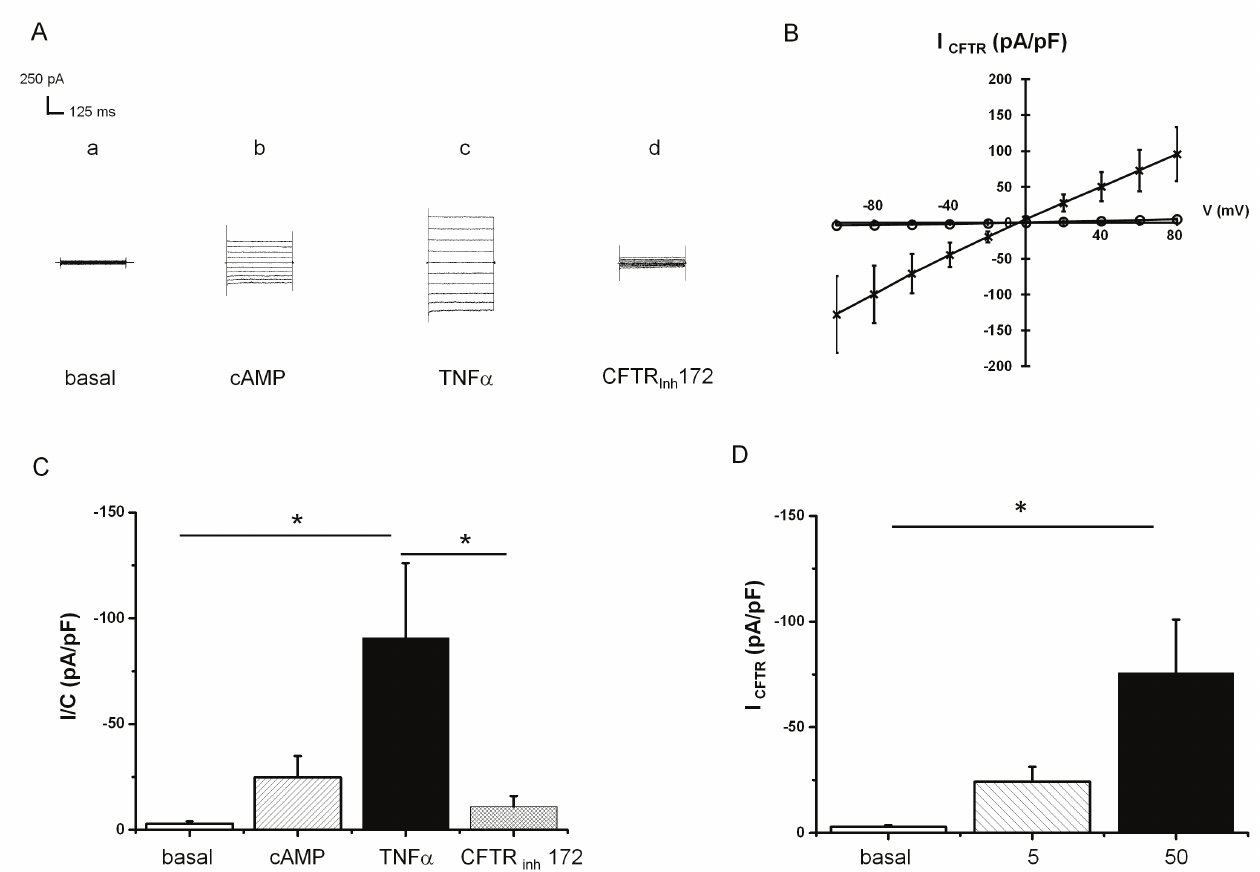
Figure 3. Effect of TNF α on whole-cell Cl - currents recorded in HeLa cells expressing F508del-CFTR by patch-clamp experiments. * indicates significant results. A . Representative current traces recorded by holding the membrane potential at 0 mV and by pulsing the voltages in the range -100 mV to +80 mV at 20 mV steps. Current traces recorded: at the basal level ( a ); in the presence of CPT-cAMP/IBMX ( b ); in the presence of 50 TNF α +CPT-cAMP/IBMX ( c ); in the presence of 5 µM CFTR 172, 50ng/ml TNF α and 400 µM CPT-cAMP/IBMX ( d ). Inh B . Mean CFTR-related current amplitudes recorded at -60 mV and normalized to cell capacitance in the presence of CPT-cAMP/IBMX ( O ); in the presence of 50 TNF α +CPT-cAMP/IBMX ( X ). C . Mean current amplitudes recorded at -60 mV and normalized to cell capacitance (means + SEM, N=8): at the basal level; in the presence of CPT-cAMP/IBMX; in the presence of 50 TNF α +CPT-cAMP/IBMX; in the presence of 5 µM